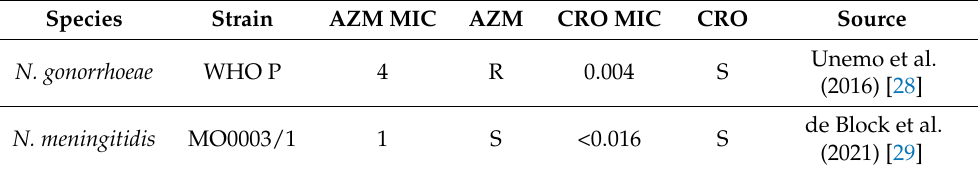
Table 1. Susceptibility values of test